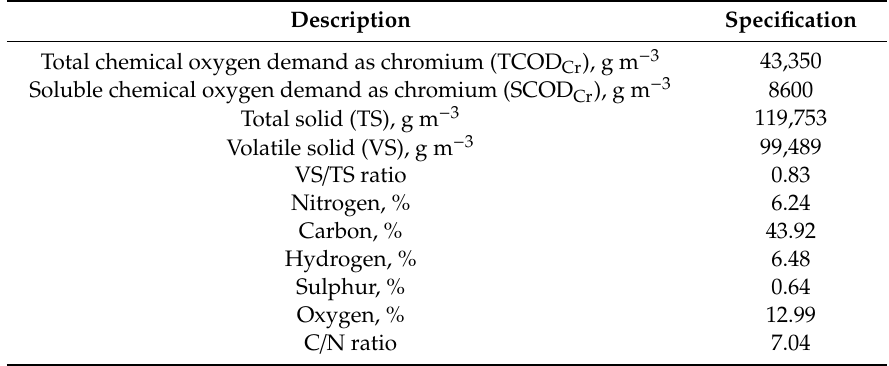
Table 1. Biochemical methane potential (BMP) test: waste hydrated sludge